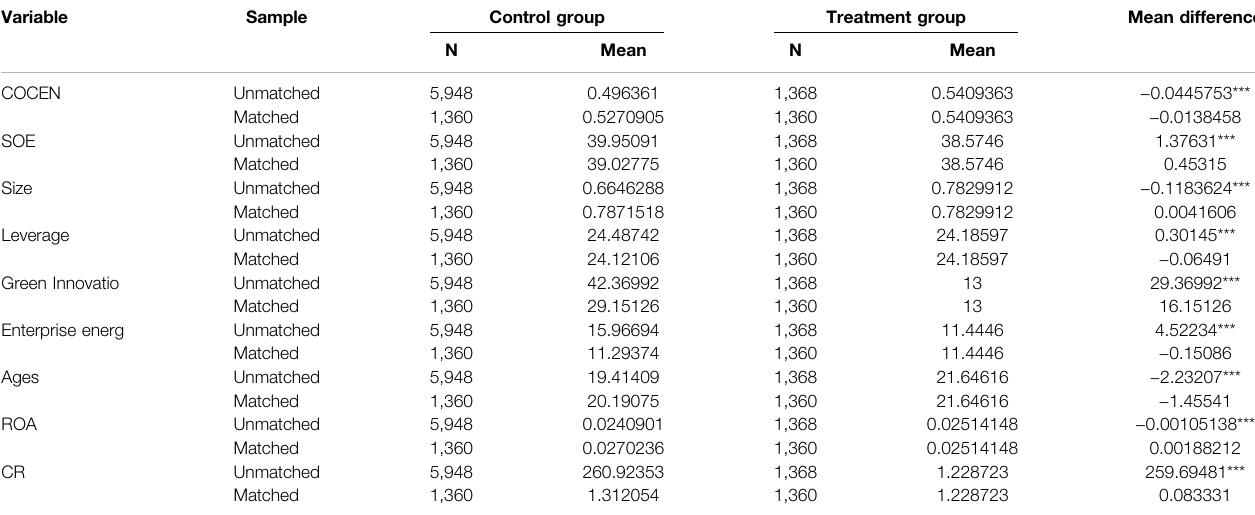
TABLE 5 | PSM balance test about excitation.